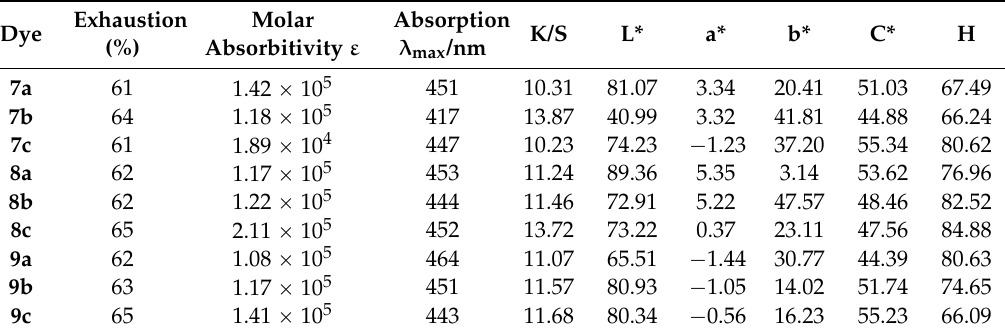
Table 2. Optical measurements of the synthesized dyes on polyester fabrics.